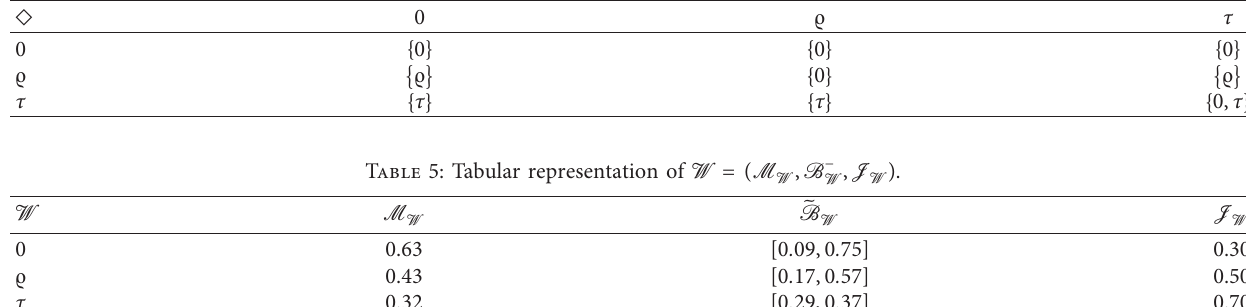
Table 4: Tabular representation of the hyperoperation “ ◇ .”